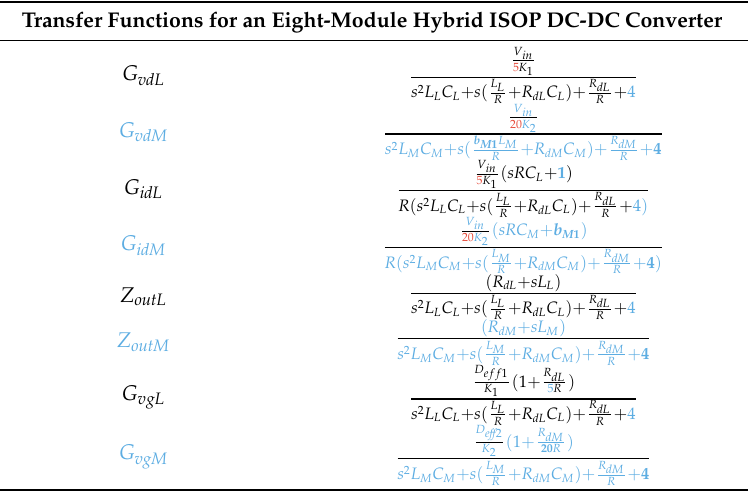
Figure 6. Hybrid ISOP DC-DC converter small-signal model for eight-modules. Table 2. Generalized model verification with the eight-module hybrid ISOP DC-DC